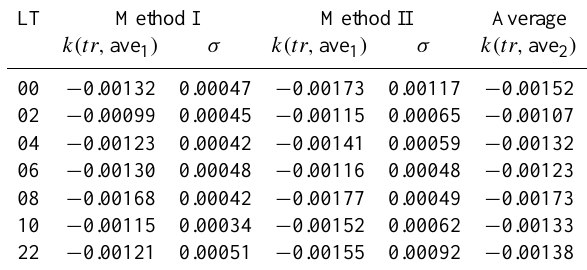
Table 4. Values of k(tr) and σ for various LT